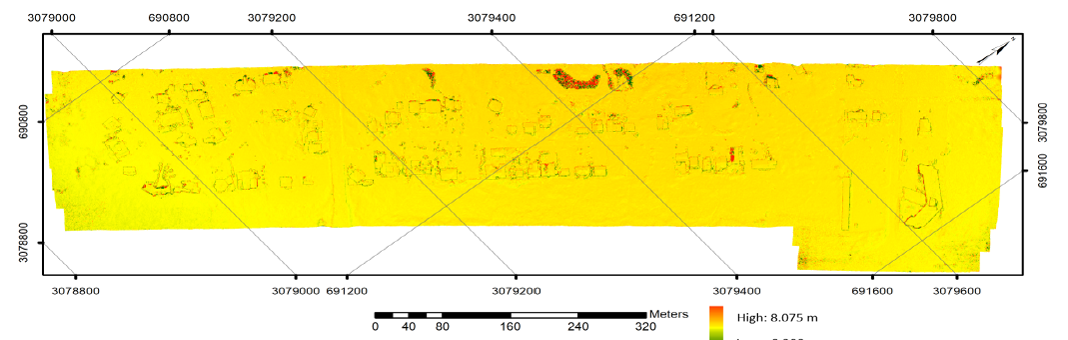
Figure 13. Illustration of DSM difference between HR gt and SR pre image set.